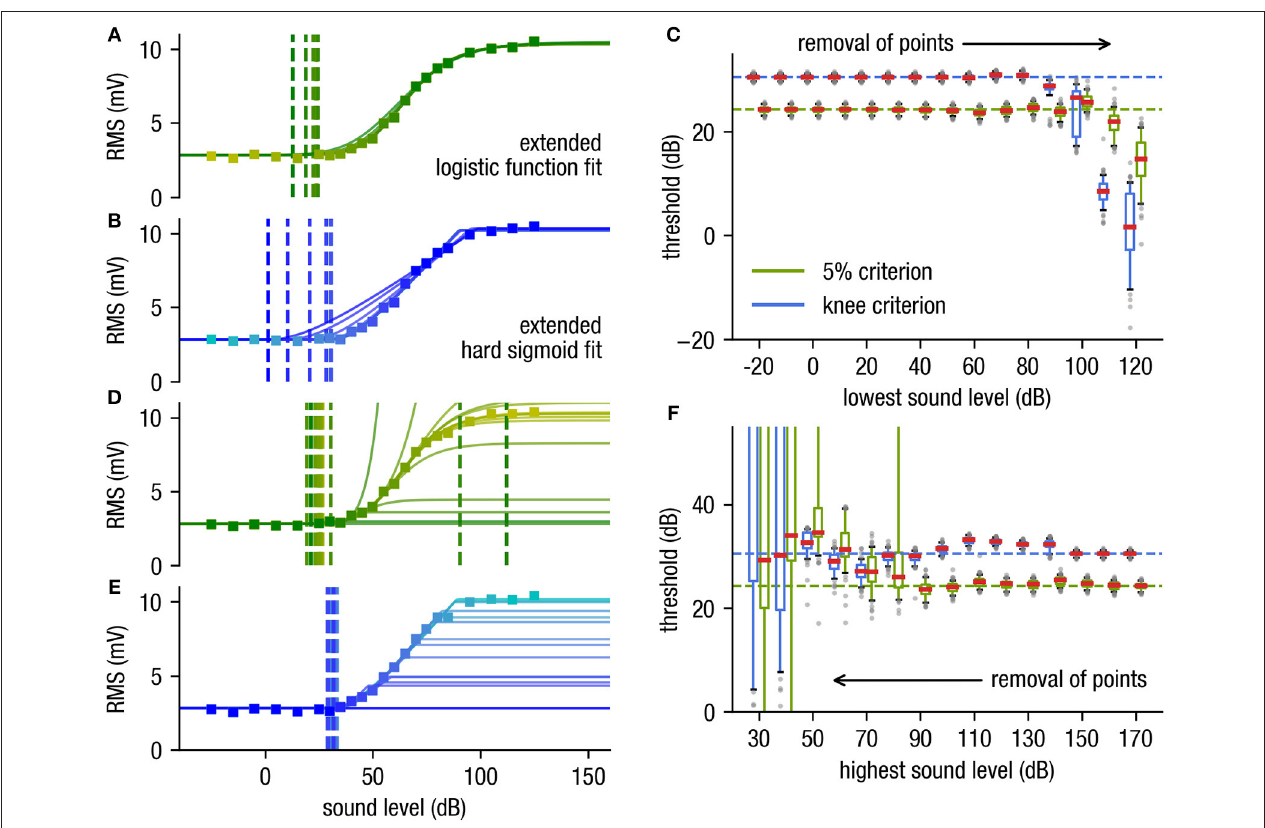
FIGURE 3 | Effect of removal of supporting points. (A,B) Stepwise removal of the supporting points starting at the sub-threshold range (starting at low stimulus intensities) for the logistic function fit with the 5%-criterion (stepwise deletion of supporting points from yellow to dark green) (A) and the hard sigmoid fit with the knee criterion (B) , from cyan to dark blue. (C) The determined threshold is very robust against deletion of supporting points near the subthreshold range where the S/N ratio is poor. (D,E) Stepwise removal of supporting points near the saturation range [starting at high stimulus intensities, yellow to green) for the logistic function fit (D) and the hard sigmoid fit (E) , from cyan to dark blue]. (F) The hard sigmoid fit is very robust against missing supporting points near the saturation range. Note that even though the used artificial data is generated using an underlying generalized logistic function the hard sigmoid fitting procedure is more stable against missing supporting points near the saturation range. This fact is important e.g., for far field potential measurements as the dynamic range of such measurements typically is very large due to the different thresholds of the involved neurons are distributed over a wide range (cf. Nizami and Schneider,